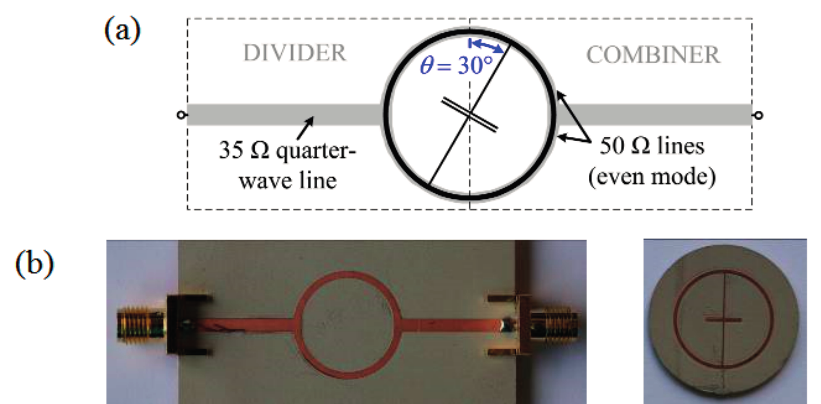
Figure 21. Angular displacement sensor. ( a ) Layout; and ( b ) photograph. The substrates are Rogers RO3010 with ε r = 11.2, h = 1.27 mm (microstrip line) and h = 0.635 mm (resonator), and tan δ = 0.0023. The line widths W are 2.06 mm and 1.04 mm. In reference to Figure 9, ELC mean radius r 0 = 8.05 mm, w 1 = 6 mm, w 2 = l 1 = s = 0.2 mm, and w 3 = 0.5 mm.